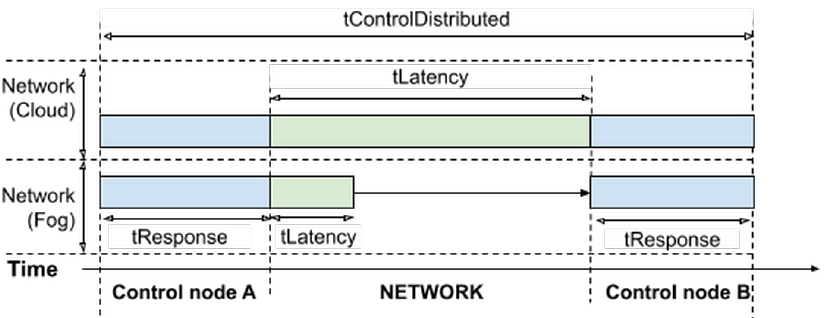
Figure 3. Times related to communications between two different control nodes (CN) connected in the fog or the